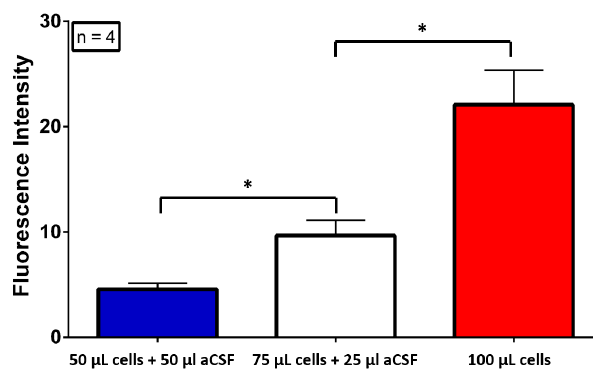
Figure 3. Glioblastoma Fluorescence Detection in aCSF in